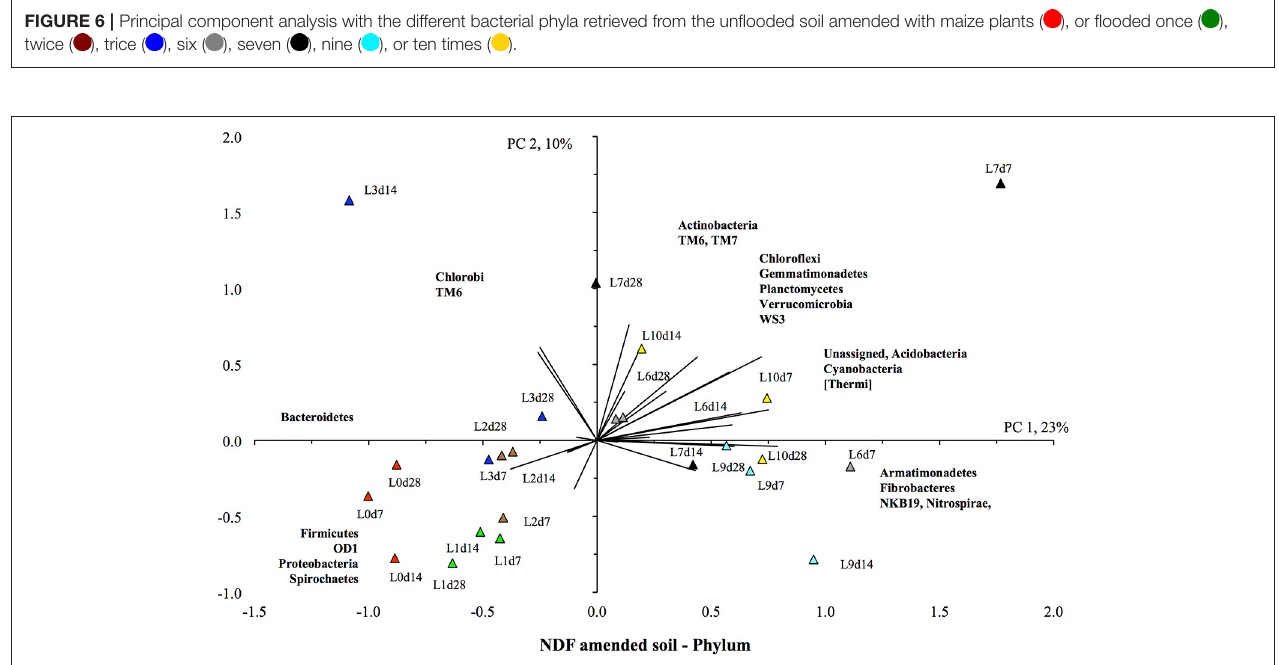
FIGURE 7 | Principal component analysis with the different bacterial phyla retrieved from the unflooded soil amended with the neutral detergent fiber fraction ( ), or flooded once